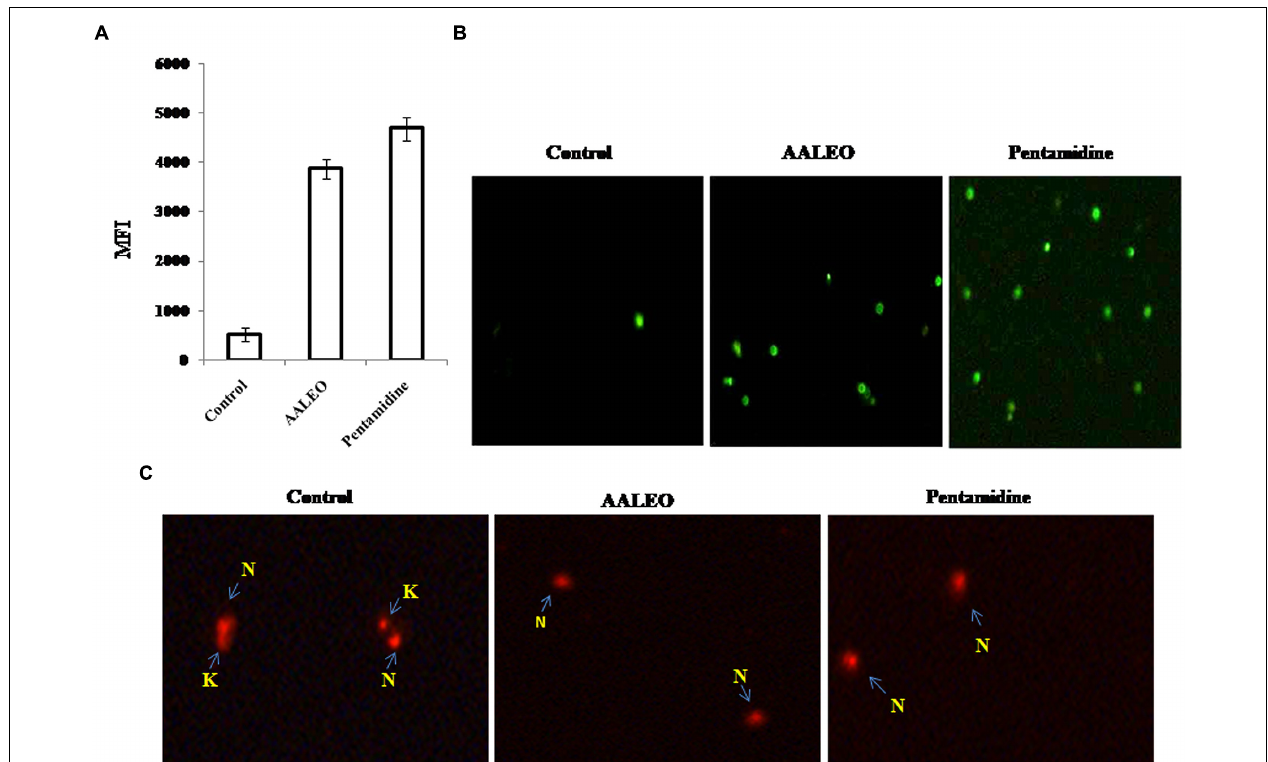
FIGURE 4 | Artemisia annua leaves treated promastigotes represent TdT-mediated dUTP nick-end labeling (TUNEL) positivity and dyskinetoplastidy. Exponential phase promastigotes were incubated with AALEO or pentamidine (100 μ g ml − 1 ) for 72 h. Cells were fixed and stained with dUTP–FITC in the presence of TdT. (A) Bar graphs representing MFI of TUNEL expression as analyzed by flow cytometry (B) Image acquisition via a fluorescence microscope under 10 ×